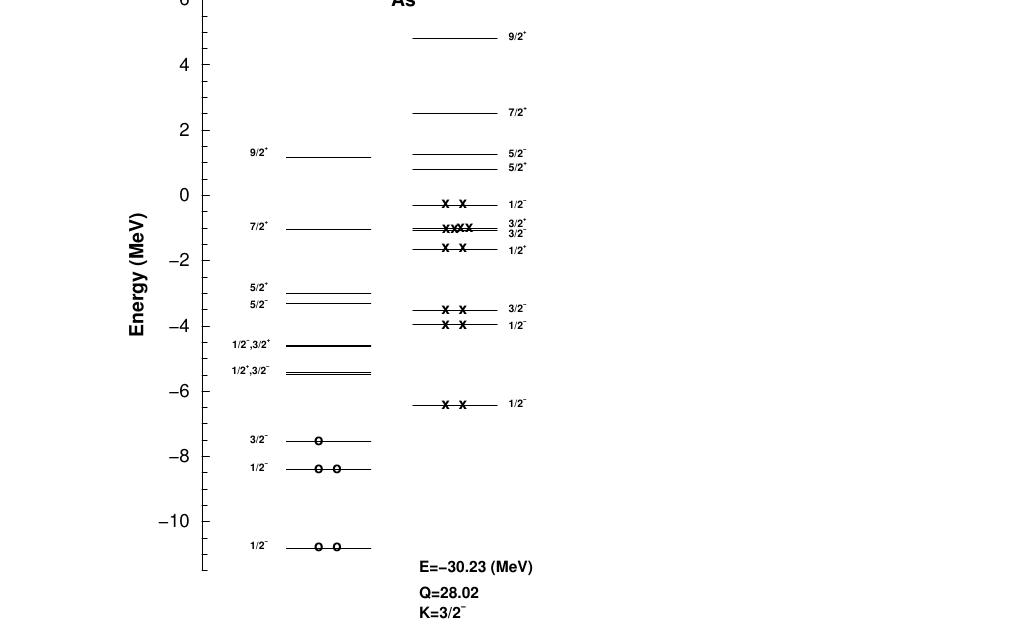
Figure 1. Hartree-Fock (HF) single-particle spectra for 75 As corresponding to lowest prolate configu- ration. In the figure, circles represent protons and crosses represent neutrons. The HF energy E in MeV, mass quadrupole moment Q in units of the square of the oscillator length parameter and the total azimuthal quantum number K are given in the figure.